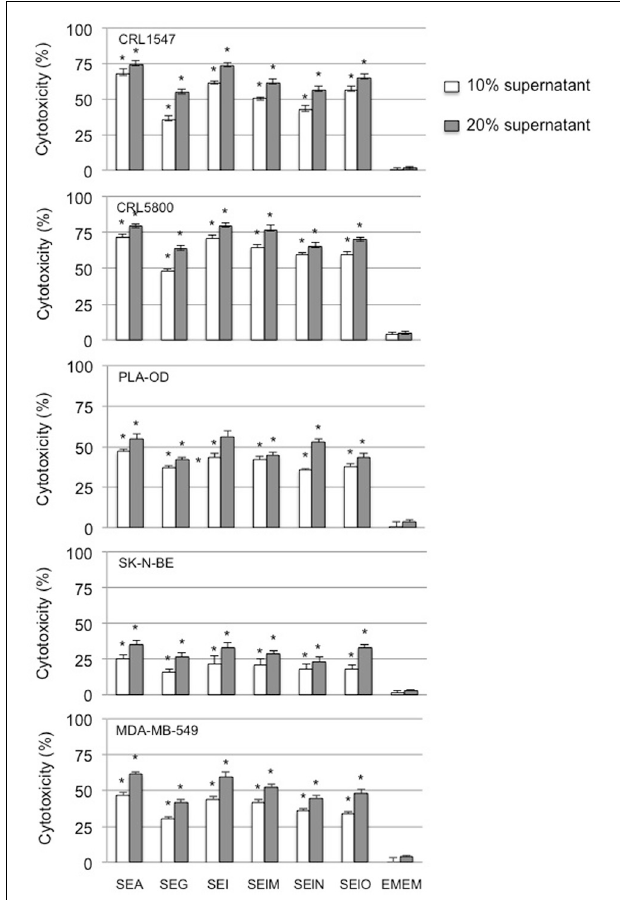
FIGURE 3 | Cytotoxicty of SEA and egcSE-stimulated PBMCs vs. a broad panel of human tumor cell lines is shown. Cytotoxicity of 72h supernatants from unstimulated PBMCs, SEA-, SEG-, SEI-, SElM-, SElN-, or SElO-stimulated PBMCs against human non-small cell lung adenocarcinoma CRL5800, osteogenic sarcoma CRL1547, human breast cancer cell line MDA-MB-549, human neuroblastoma cell line SK-N-BE and human melanoma PLA-OD were examined as described in Figure 2 . Results are mean ± SEM ( n = 3 independent experiments). Asterisks indicate statistical significance compared to the untreated PBMC control values at 10 or 20% concentrations.